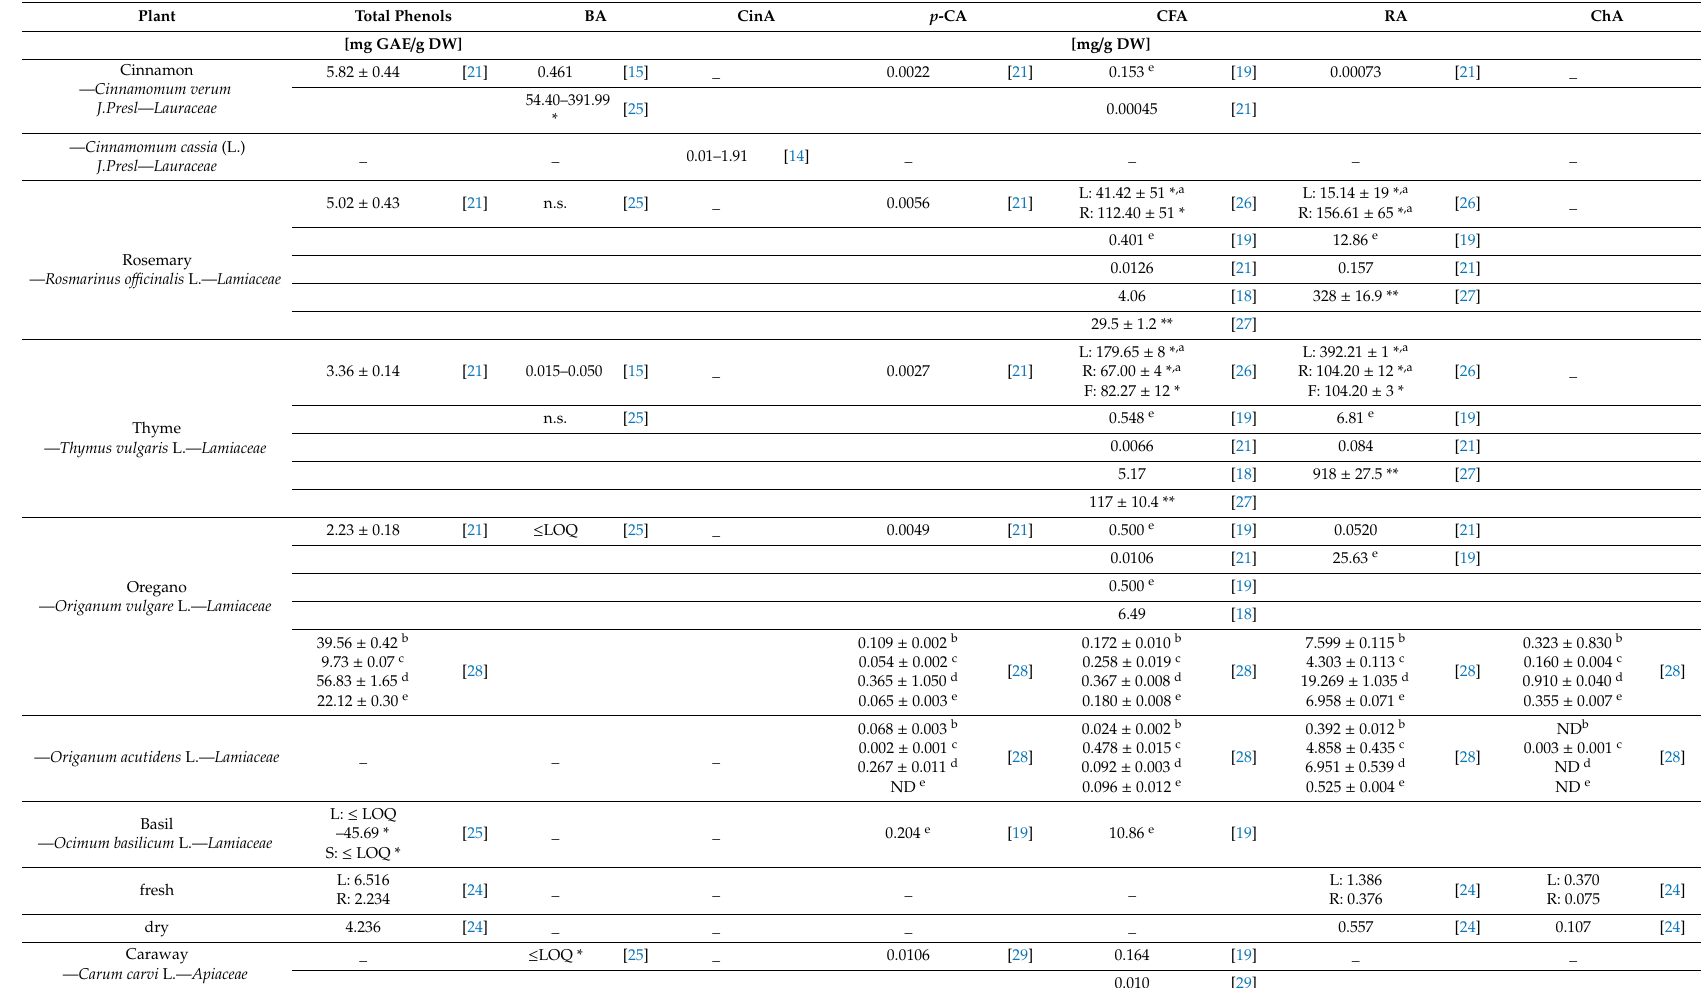
Table 1. Concentration of NCA in di ff erent aromatic plants (herbs and